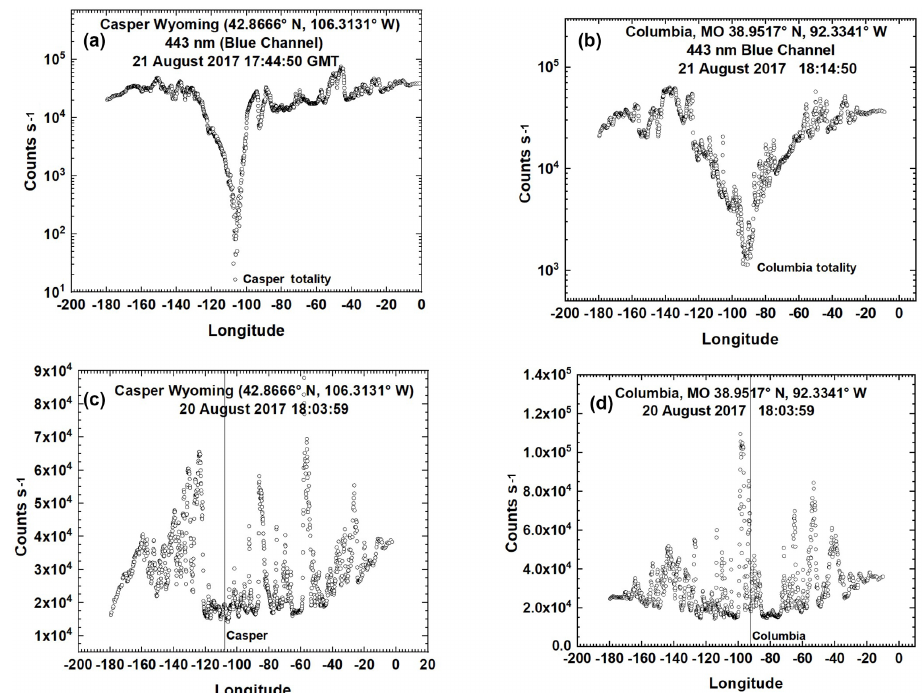
Figure 5. (a, b) The effect of an eclipse (21 August) on the measured counts per second reflected back to space as a function of longitude (degrees) for two locations: Casper, Wyoming (a, c) , and Columbia, Missouri (b, d) . (c, d) Measured counts per second reflected back to space on 20 August. A log 10 scale is used to show details of the spatial variability mostly caused by clouds.